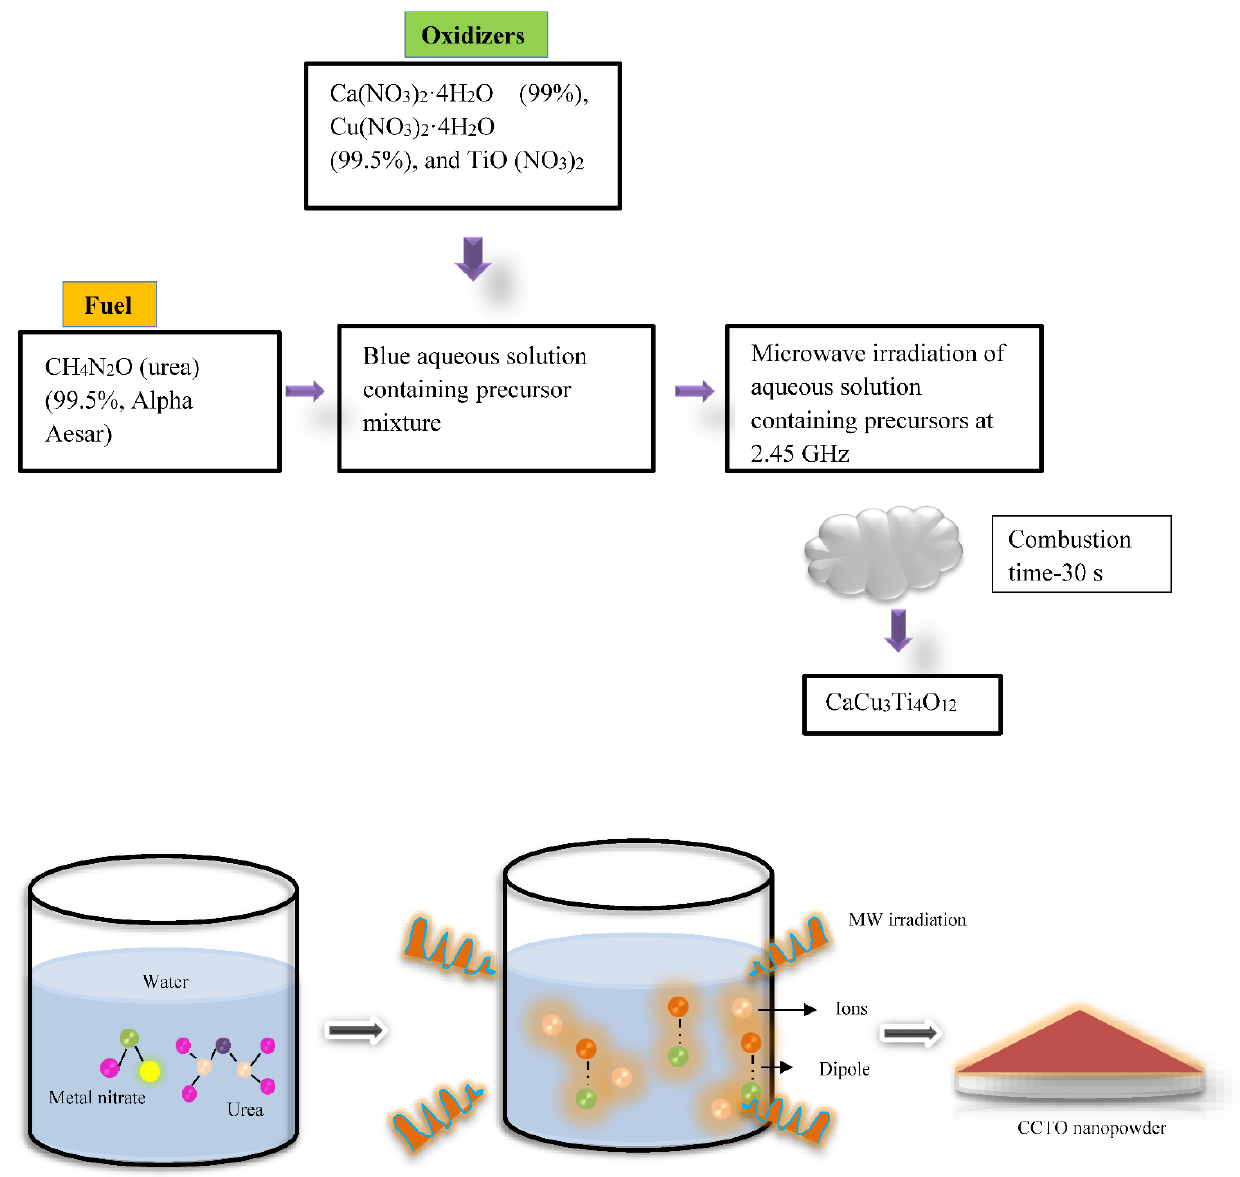
Figure 3. Schematic representation of microwave flash combustion method for production of CCTO powder (50–70 nm).